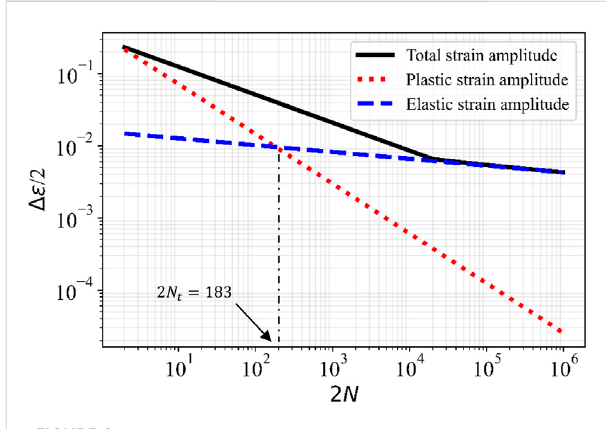
FIGURE 9 Total, plastic, and elastic strains amplitude versus number of reversed cycles to failure (when, σ m